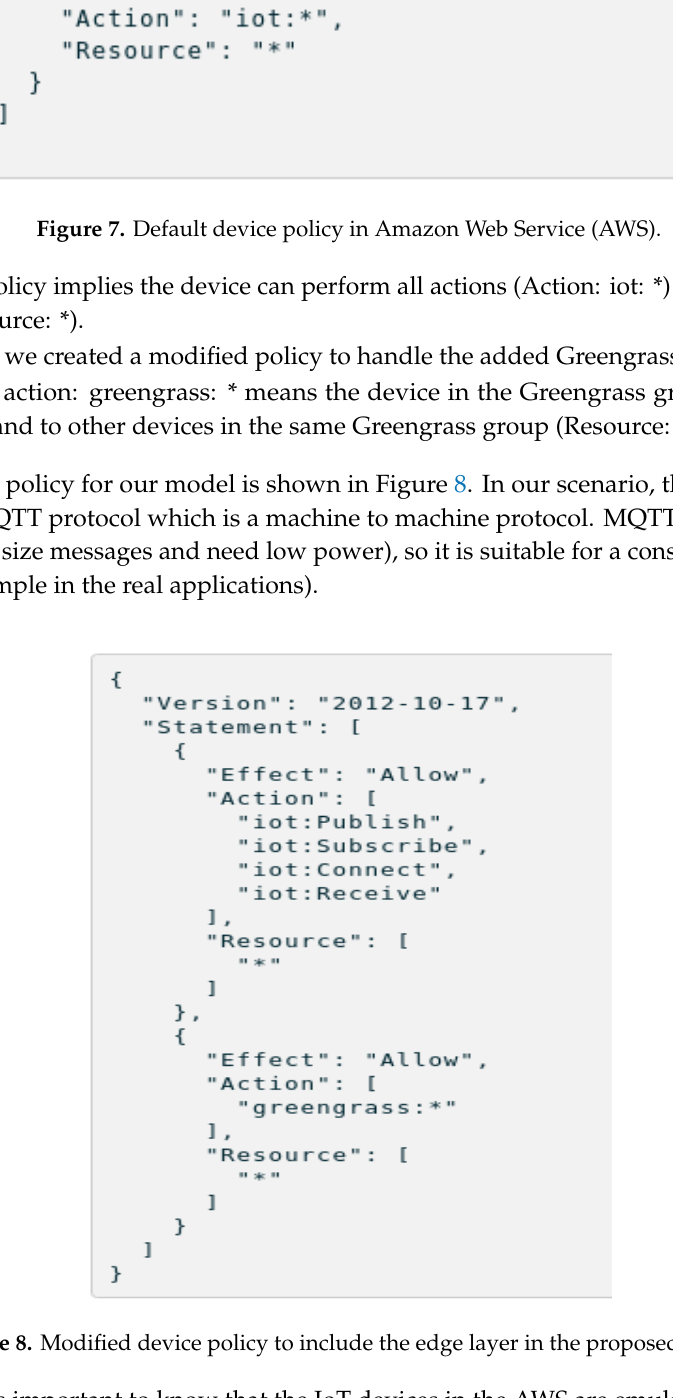
Figure 9. The Raspberry Pi 4 kit setup.